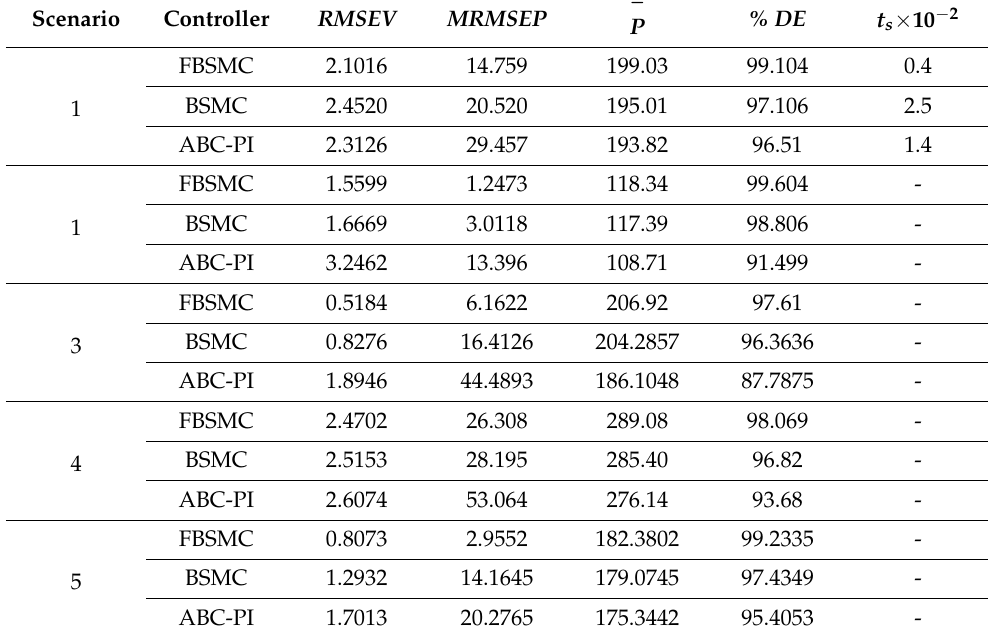
Table 5. Quantitative Evaluation of